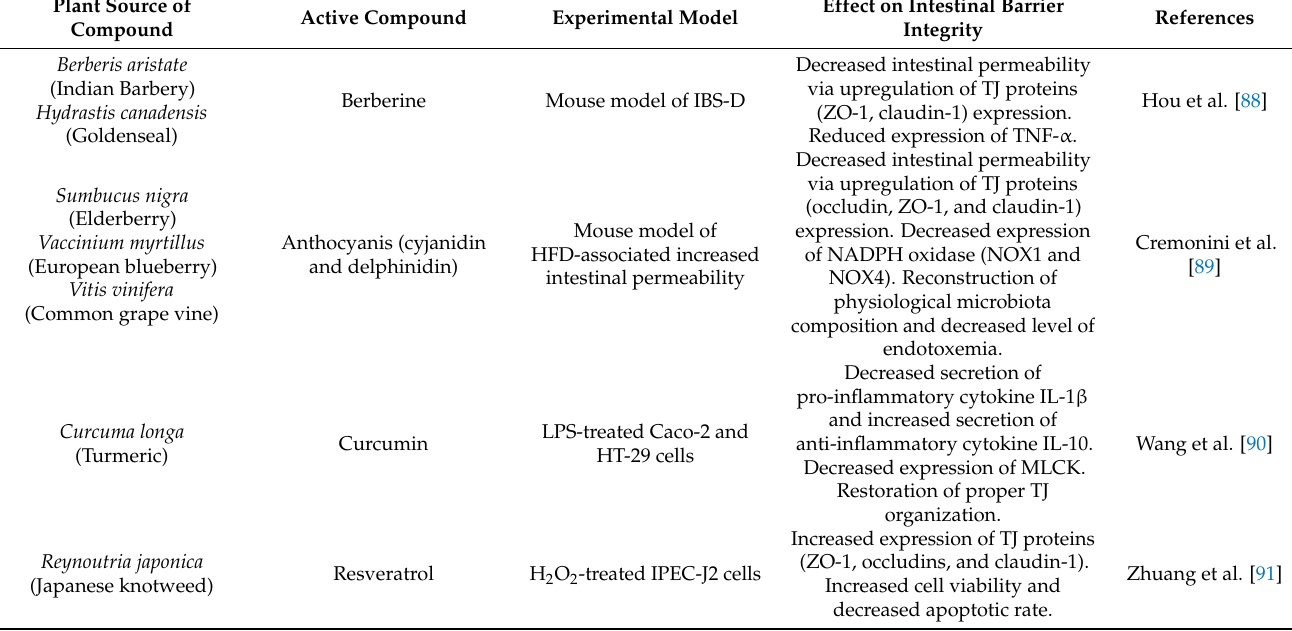
Table 1. Effect of selected phytochemicals on intestinal barrier